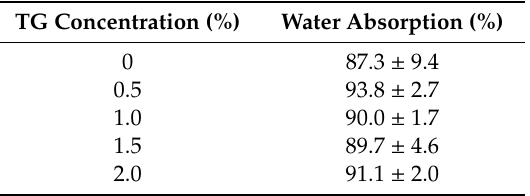
Table 2. Water absorption (%) (± S.D.) rates of noodles at different transglutaminase (TG) concentrations (%) with cooking.